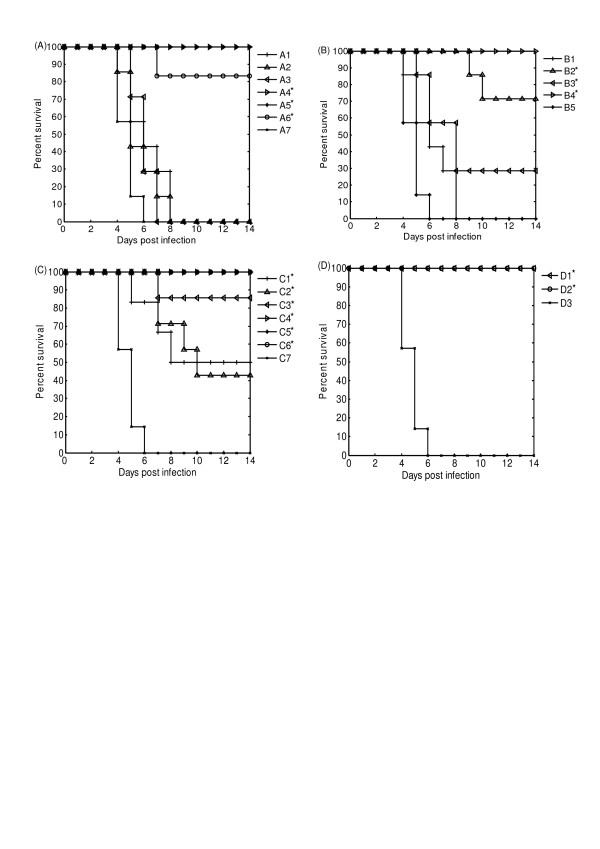
Survival of offspring after lethal A/PR8/34 virus challenge. The offspring were vaccinated as described in result section. One week after second immunization, the offspring were challenged with a lethal dose of A/PR/8/34 (20 × LD50). Survival rates of mice were measured after viral challenge. Panel A: (A1) Immunization of both mothers and the offspring with 1.0 μg of inactivated vaccine; (A2) Immunization of both mothers and the offspring with 0.1 μg of inactivated vaccine; (A3) Immunization of both mothers and the offspring with 0.01 μg of inactivated vaccine; (A4) Immunization of offspring born to unimmunized mothers with 1.0 μg of inactivated vaccine; (A5) Immunization of offspring born to unimmunized mothers with 0.1 μg of inactivated vaccine; (A6) Immunization of offspring born to unimmunized mothers with 0.01 μg of inactivated vaccine; (A7) Negative control. Panel B: (B1)Immunization of both mothers and the offspring with 30 μg of HA DNA; (B2) Immunization of offspring born to unimmunized mothers with 30 μg of HA DNA; (B3) Immunization of both mothers and the offspring with 30 μg of NA DNA; (B4) Immunization of offspring born to unimmunized mothers with 30 μg of NA DNA; (B5) Negative control. Panel C: (C1) Immunization of mothers with1.0 μg of inactivated vaccine and the offspring with 30 μg of HA DNA; (C2) Immunization of mothers with 0.1 μg of inactivated vaccine and the offspring with 30 μg of HA DNA vaccine; (C3) Immunization of mothers with 0.01 μg of inactivated vaccine and the offspring with 30 μg of HA DNA; (C4) Immunization of mothers with 1.0 μg of inactivated vaccine and the offspring with 30 μg of NA DNA; (C5) Immunization of mothers with 0.1 μg of inactivated vaccine and the offspring with 30 μg of NA DNA; (C6)Immunization of mothers with 0.01 μg of inactivated vaccine and the offspring with 30 μg of NA DNA; (C7) Negative control. Panel D: (D1) Immunization of mothers with 30 μg of HA DNA and the offspring with 30 μg of NA DNA; (D2) Immunization of mothers with 30 μg of NA DNA and the offspring with 30 μg of HA DNA; (D3) Negative control. *Significant differences (p < 0.05) compared to negative controls as determined by Log Rank test.